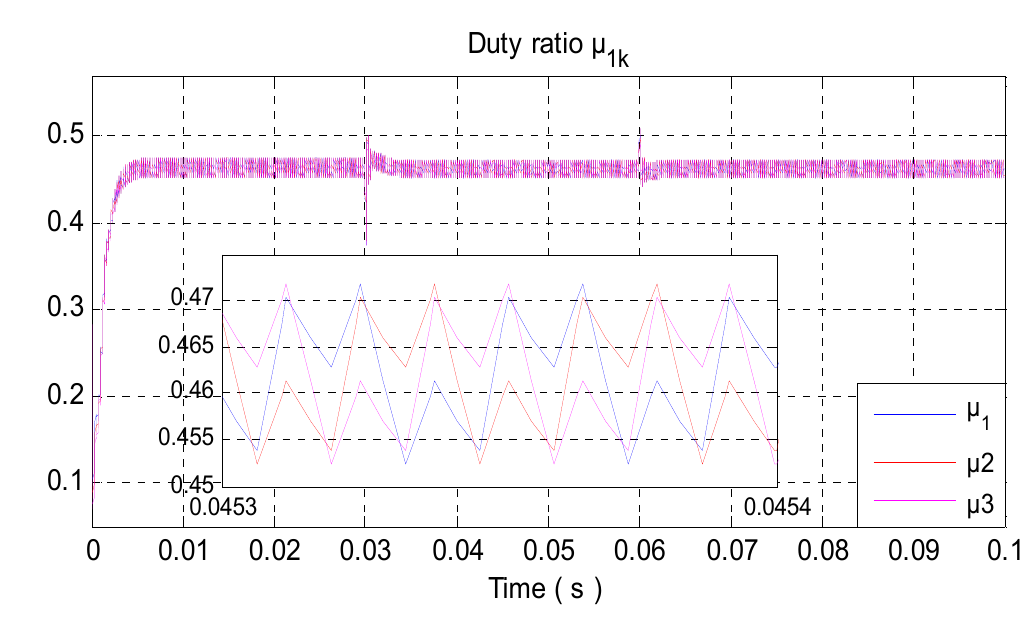
Figure 15. Control signals μ 1 k with zoom.